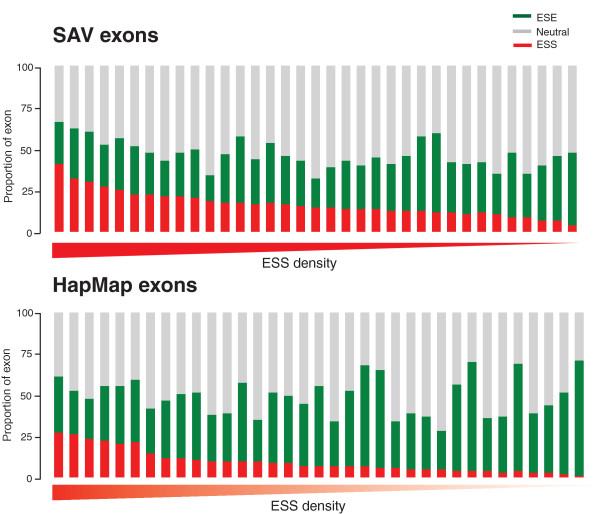
Exons containing SAVs have significantly lower ESE and significantly higher ESS densities than exons containing hSNPs. As an illustration, the proportion of overlapping hexamers that are considered ESEs (green), ESSs (red) or splice neutral (grey) was plotted for 35 exons containing SAVs (that cause ESE/ESS changes) and a set of 35 randomly selected, length-matched hSNP-containing exons. Exons in both sets are sorted in descending order by ESS density.